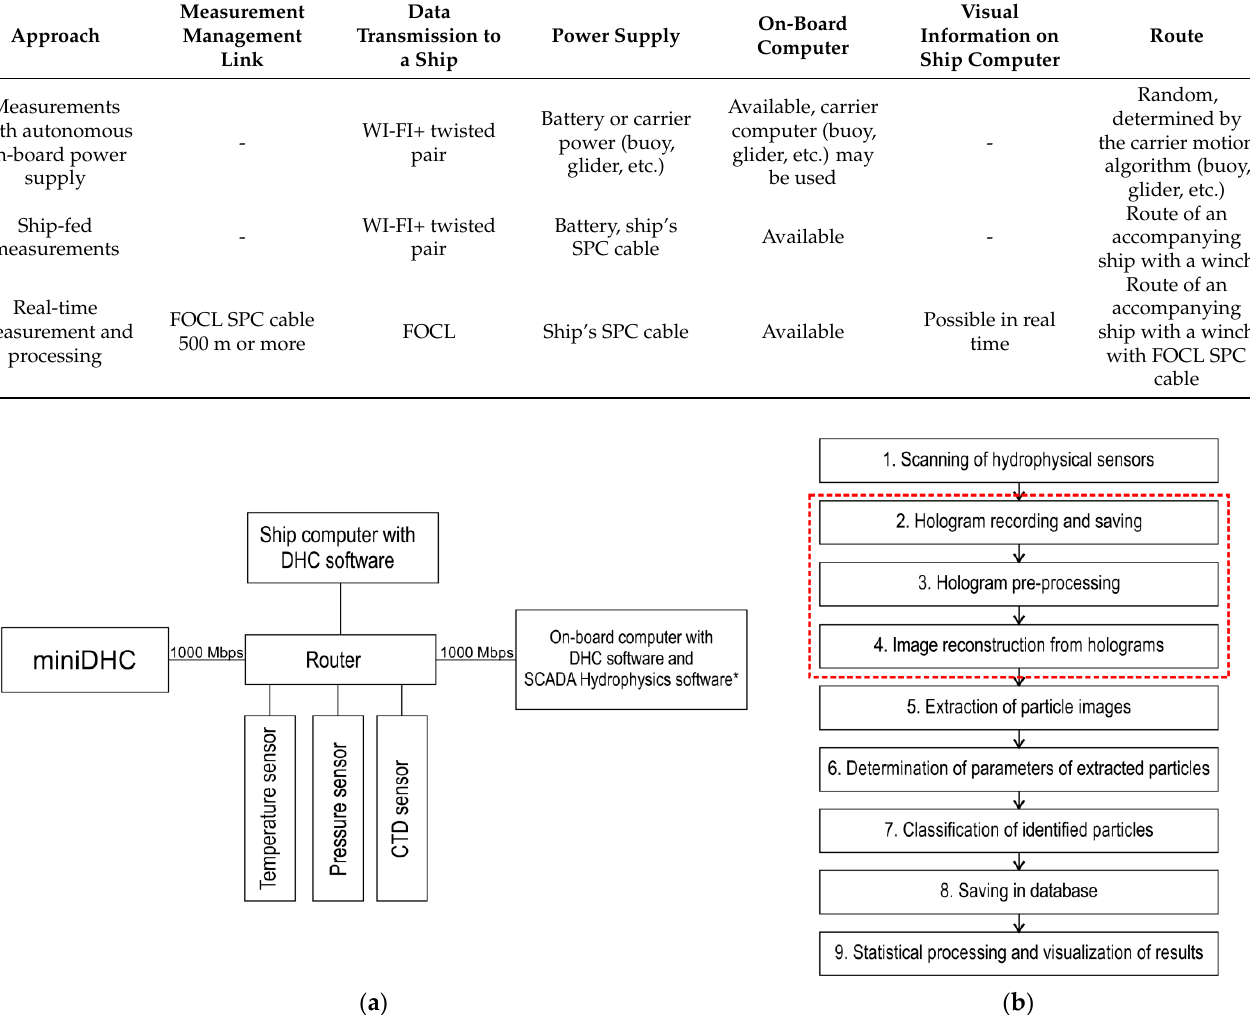
Figure 3. ( a ) Structure of interaction between hydrobiological probe devices, ship computer, and their software. *-optional. ( b ) Structure of the DHC software. The DHC basic software is marked red.